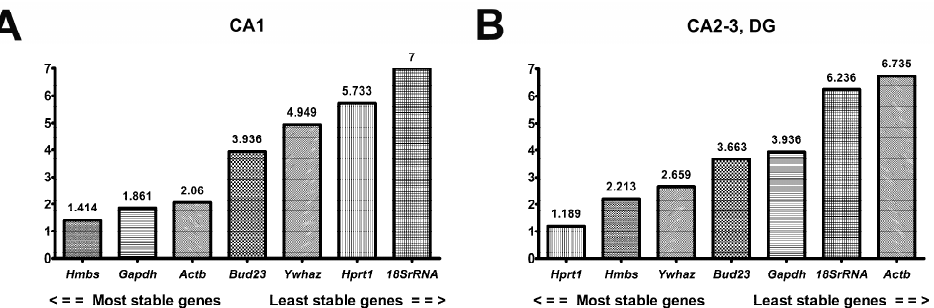
Figure 4. RefFinder stability rankings of 7 candidate reference genes in CA1 and CA2-3,DG parts of hippocampus, calculated separately ( A , B ). Data are presented from the most stable (left) to the least stable gene. n = 15.